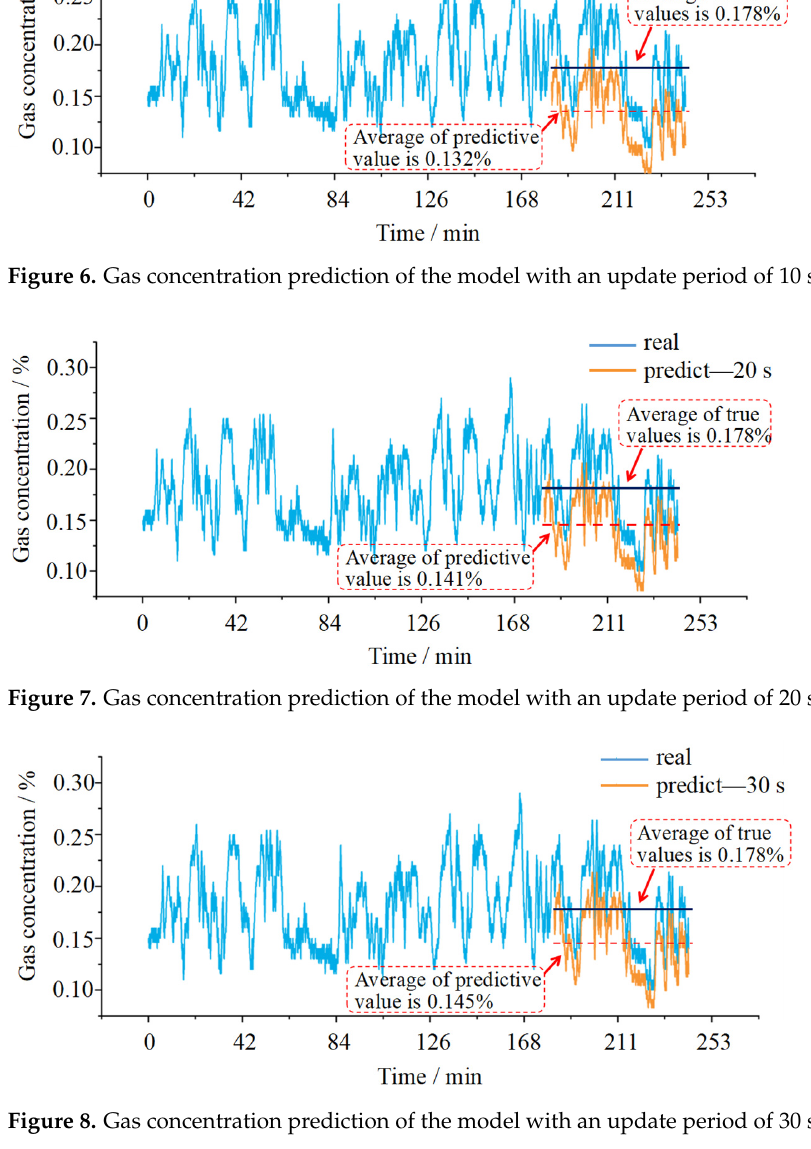
Figure 9. Gas concentration prediction of the model with an update period of 40 s.